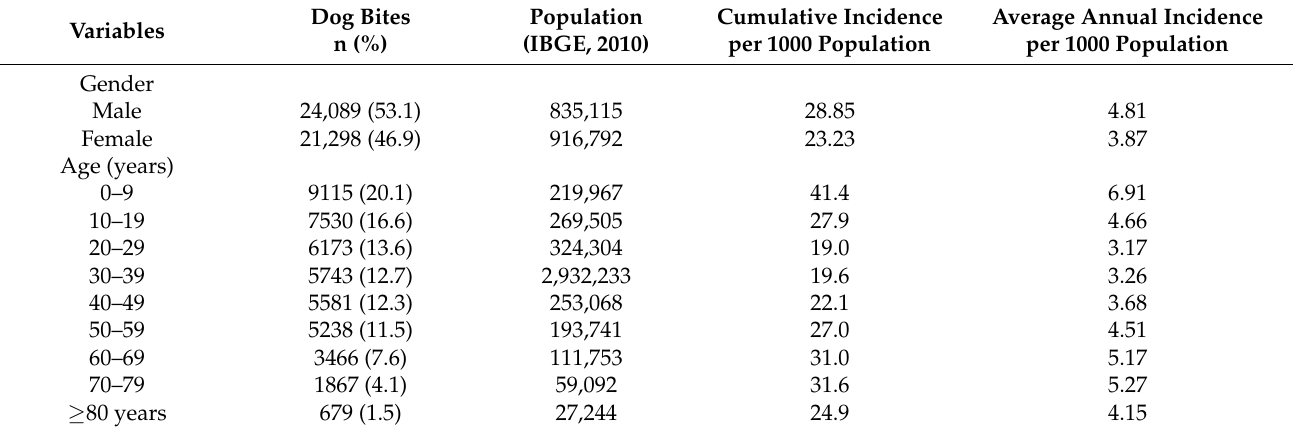
Table 1. Distribution of the variables and incidence per 1000 habitants related to gender, age, and race/color of dog bite victims in Curitiba based on PEP reports, Southern Brazil, between 1